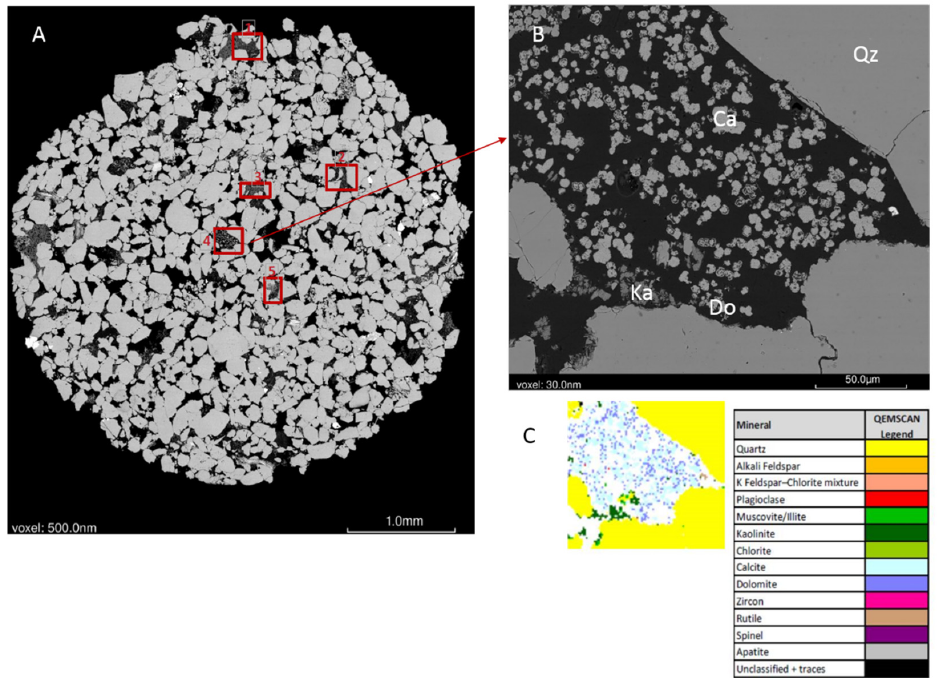
Figure 8. ( A ) Post-reaction SEM image of the polished sub-plug slice. Boxes indicate positions of magnified areas shown in the supplementary material. ( B ) SEM image from box 4 in ( A ), with calcite and dolomite filling an intergranular pore. ( C ) QEMSCAN image of the same area in ( B ) with the mineral legend. Ca: Calcite; Do: Dolomite; Qz: Quartz; Ka: